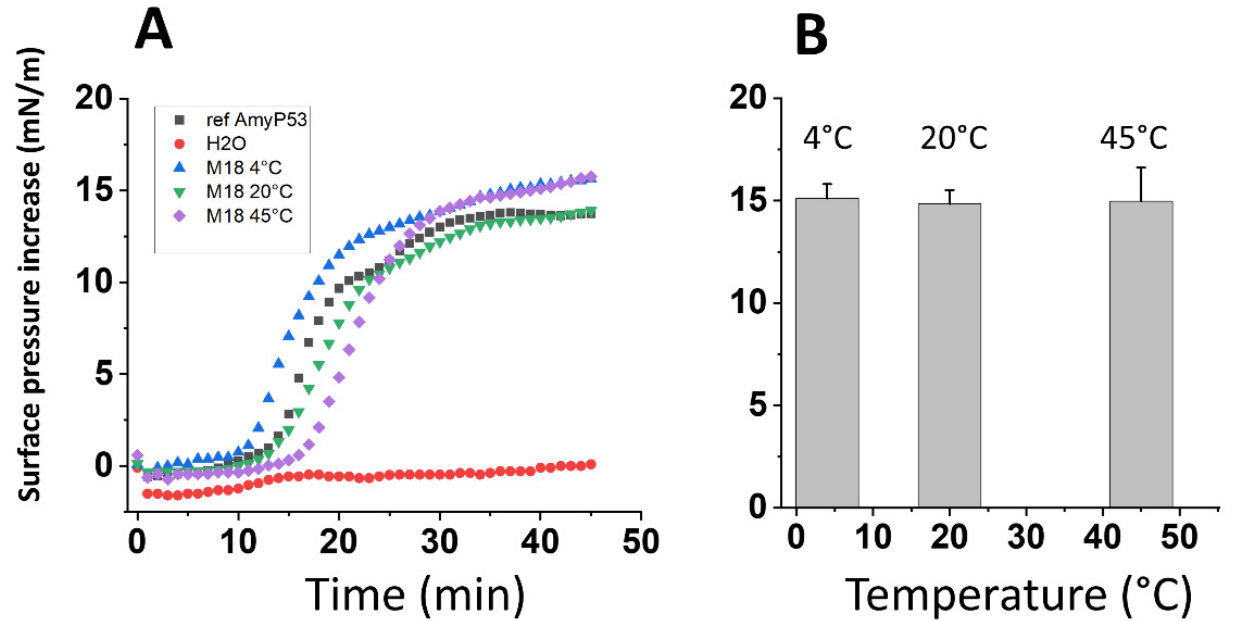
Figure 3. Biological stability of AmyP53 in aqueous solution. AmyP53 was dissolved in pure water at a concentration of 1 mM and stored for a maximal time of 18 months at 4 °C, 20 °C, and 45 °C. ( A ) After 18 months (M18) of storage at the indicated temperature, samples were assayed in the GM1 binding assay. Pure water was used as negative control for the Langmuir monolayer assay. ( B ) Comparison of AmyP53 binding to GM1 over a 18-month period at 4 °C, 20 °C, and 45 °C. Samples were analyzed at 24 h, 48 h, 72 h, 16 days, 2 months, and 18 months. The surface pressure increase induced by 8 µL of each sample added underneath a stable monolayer of ganglioside GM1 was measured at the end of the experiment. Data are expressed as mean ± SD (n = 6). The differences between AmyP53 concentrations at 4 °C, 20 °C, and 45 °C were statistically not significant ( p > 0.05, Kruskal–Wallis test).